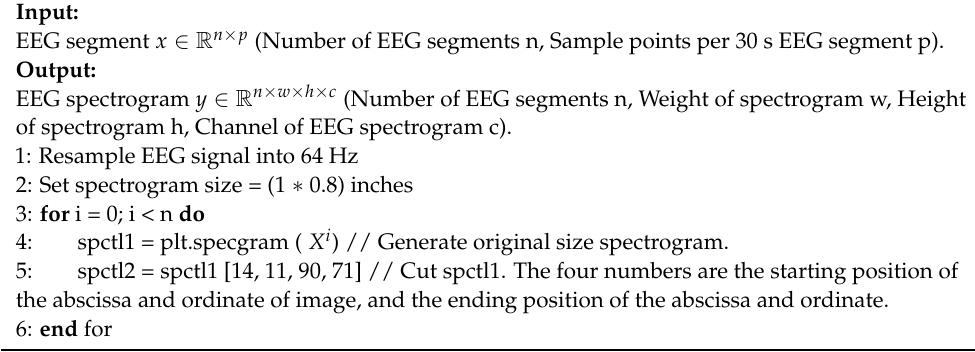
Figure 5. Schematic diagram of EEG generation, cropping and array transformation from signal to spectrogram. Algorithm 1 The description of EEG spectrogram